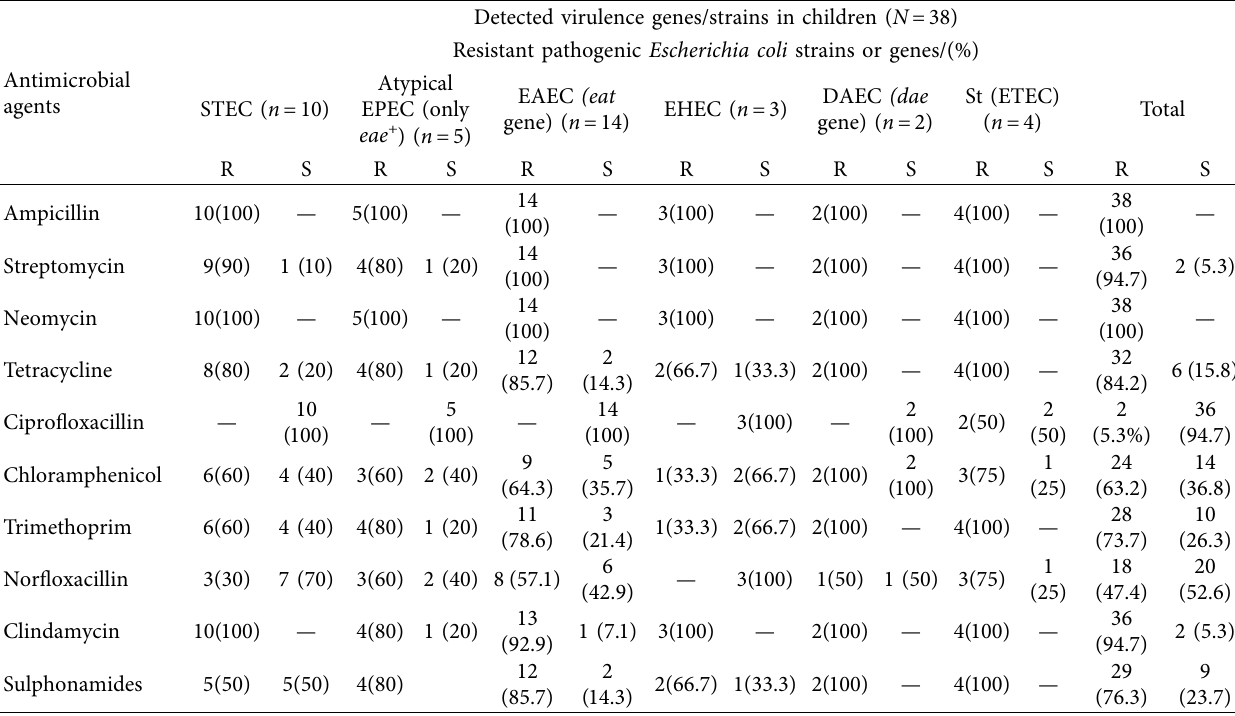
Table 5: Antimicrobial resistance percentage of pathogenic Escherichia coli strains/virulence genes.